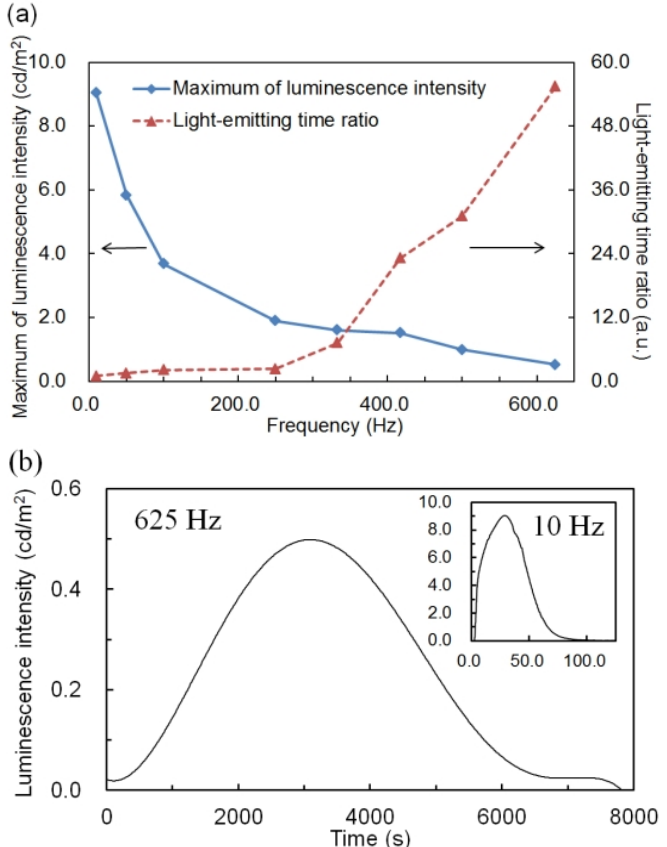
Figure 4. ( a ) Maximum of luminescence intensity (square blue plot and solid line) and light-emitting time ratio (triangle red plot and dashed line) of the poly(3-octylthiophene-2,5-diyl) electrochemiluminescence device with different applied frequencies from 10 to 625 Hz. Applied voltage is AC voltage of 5.0 V and additive concentration of perylene is 1.0 wt %. ( b ) Time variation of luminescence intensity under the application of AC voltage of 5.0 V at 625 Hz and that of 5.0 V at 10 Hz